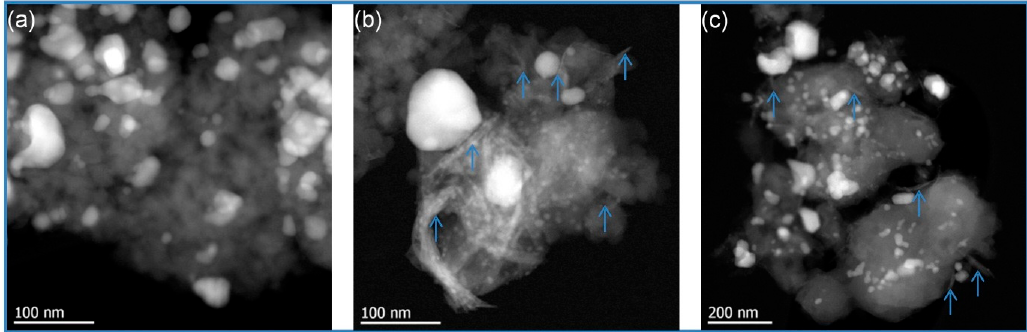
Figure 5. TEM images of 21Ni/HZSM-5. ( a ) Pre-reduced; ( b ) after 8 h on-stream and ( c ) after 24 h on-stream (arrows indicate the band particles).